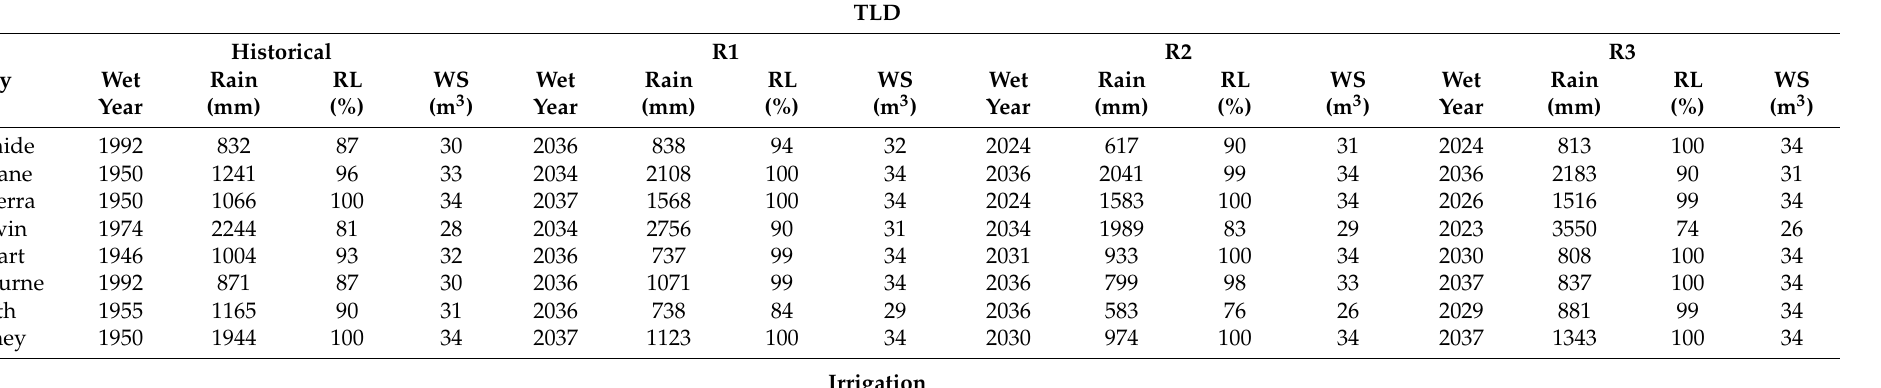
Table 4. Summary of wet year rainfall, reliability and water savings for all the eight cities for both the historical and future period (TLD and irrigation use).